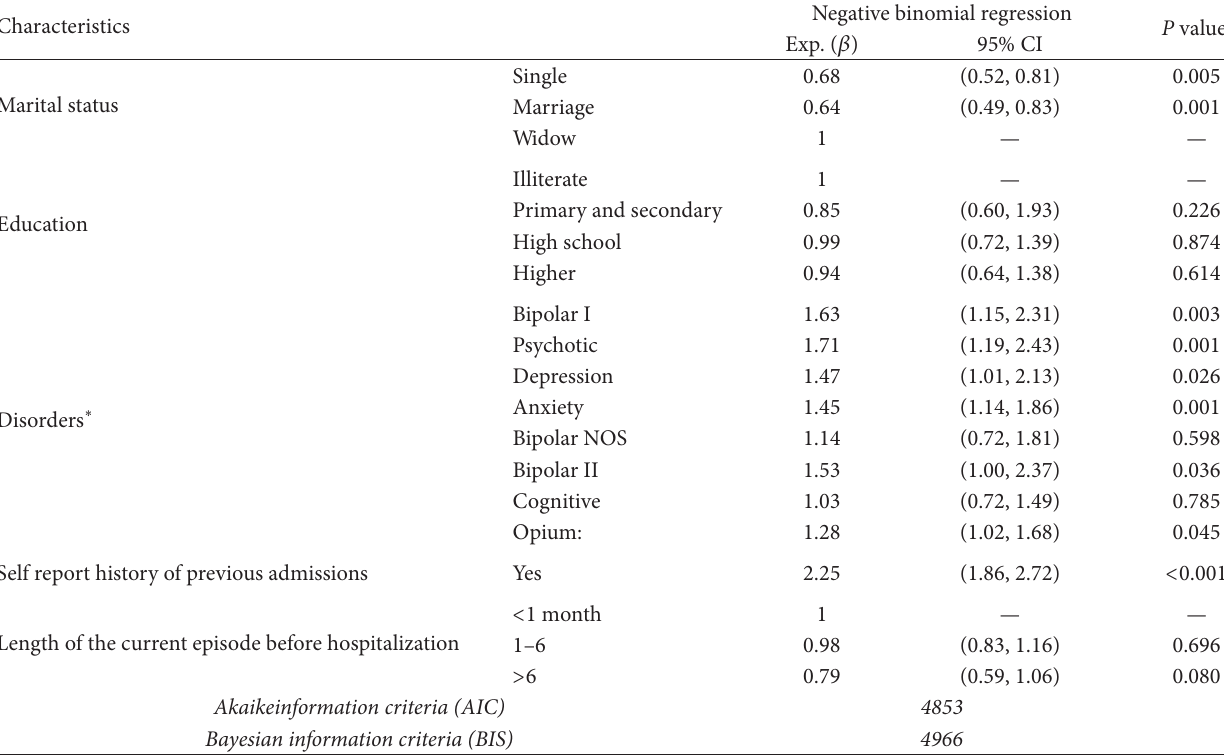
T 3: Results from �tting model of the negative binomial regression of psychiatric disorder patients at Nour (the Psychological Ward) Hospital, Isfahan, Iran, from 2004 to